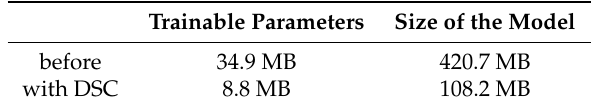
Table 14. Size of the model before and after applying the DSC on the U-Net network. Trainable Parameters Size of the Model